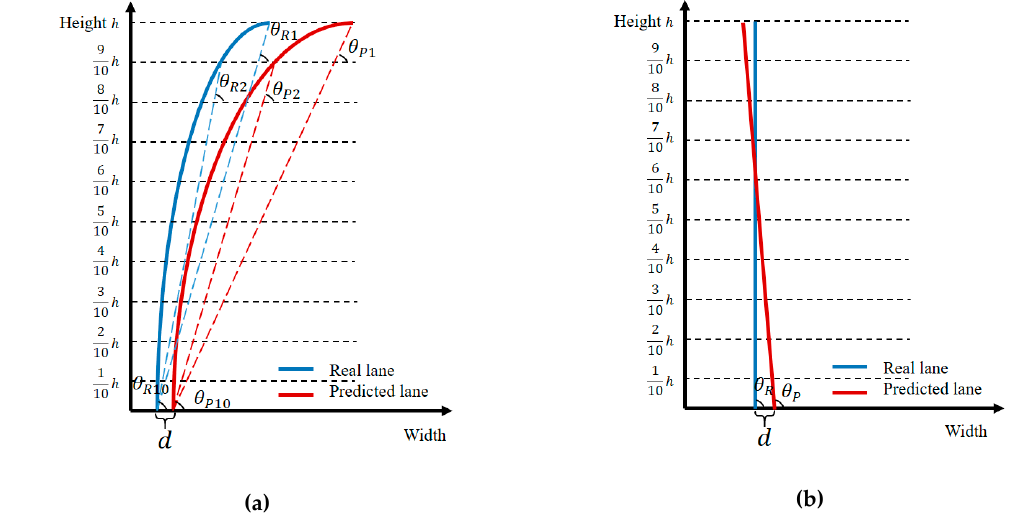
Figure 10. Illustration of lane departure index (LDI). ( a ) Curved lane in an aerial view map. ( b ) Straight lane in aerial view map.